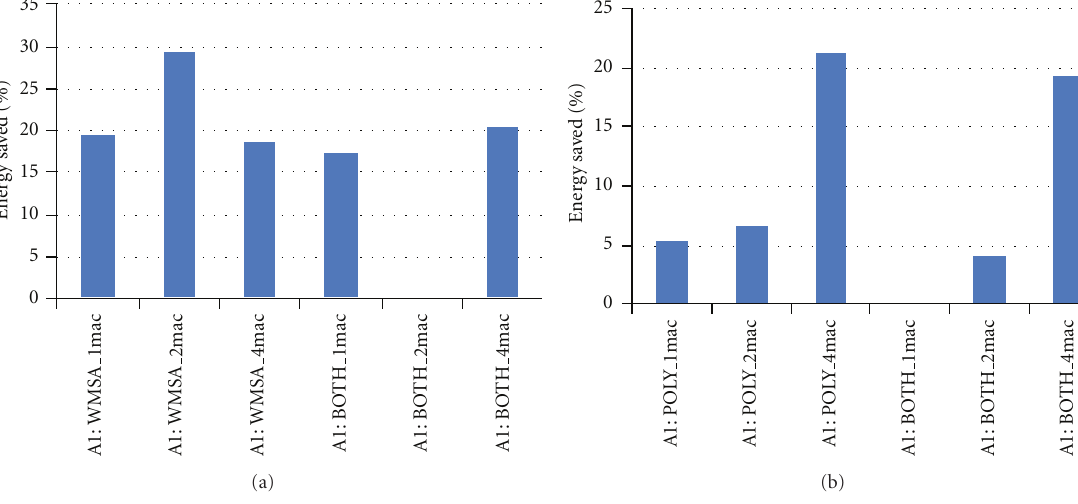
Figure 12: 64-bit: dedicated A1 versus hybrid A1 energy consumption normalized to worst case. WMSA (a) and PI